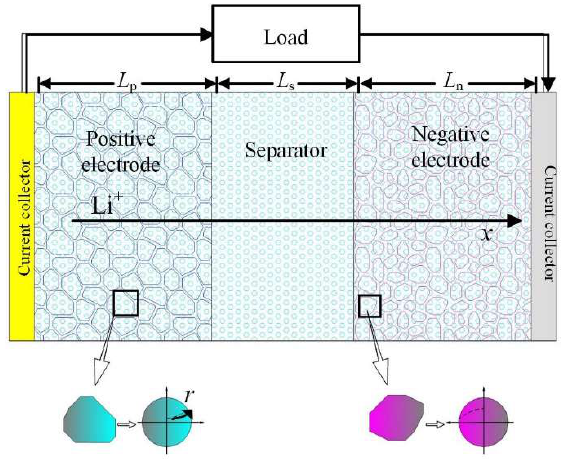
Figure 1. The schematic diagram of P2D model.